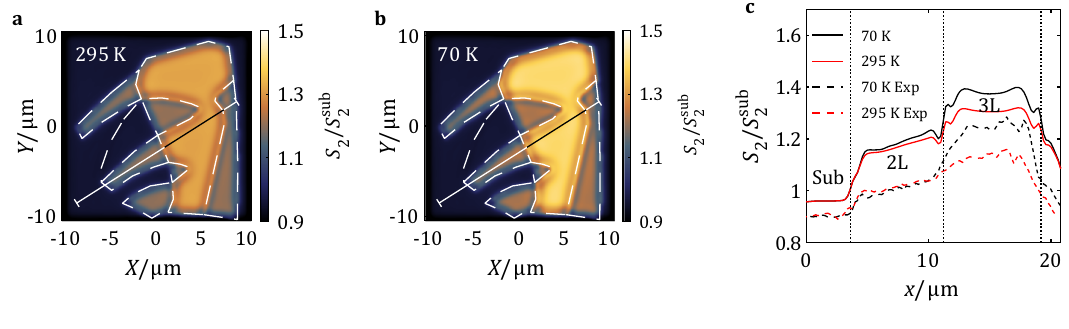
) pattern associated with SPP at 295 K ( a ) and 70 K ( b ) Fig. 6 Real-space modeling of SPP pattern. a , b Result of the model real-space near- fi eld ( S 2 = S sub 2 on the investigated sample geometry. Dashed lines highlight the physical boundaries of all regions. Line-cuts across 2L and 3L WTe 2 are indicated by the solid line in both images. c Model S 2 = S sub line-cuts extracted from a and b are plotted in solid lines. Along with the model result, experiment line-cuts are 2 displayed in dashed lines and are shifted vertically